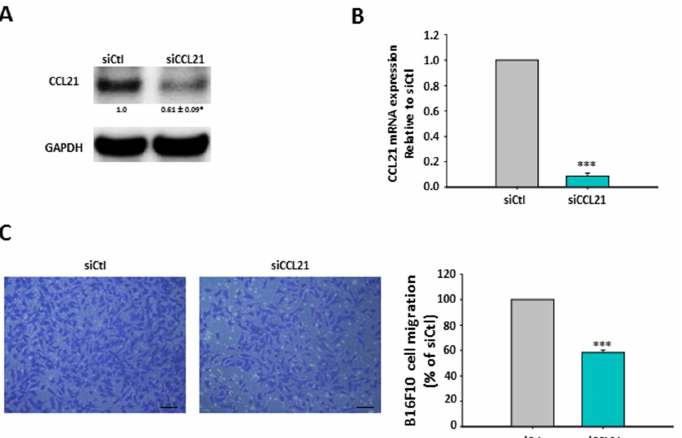
Figure 5. Effect of hMSCs’ CCL21 knockdown on B16F10 cell migration. Western blot analysis of intracellular CCL21 protein ( A ) and RT-PCR for intracellular CCL21 mRNA expression ( B ) in hMSCs infected with scrambled siRNA (siCtl) or CCL21 siRNA (siCCL21). Western blot images are shown as representative of at least three independent experiments with similar results and GAPDH was used as a loading control. The relative mRNA levels are presented as the mean ± SEM of three independent experiments. *** p < 0.001 as compared with siCtl. ( C ) Migration of B16F10 cells toward conditioned media from hMSCs infected with scrambled siRNA (siCtl) or CCL21 siRNA (siCCL21). Left panel: representative images of the migration of B16F10 cells by crystal violet staining. Scale bar: 20 µ m. Right panel: quantification of the migration of B16F10 cells. Data are presented as the mean ± SEM of three independent experiments. *** p < 0.001 as compared with